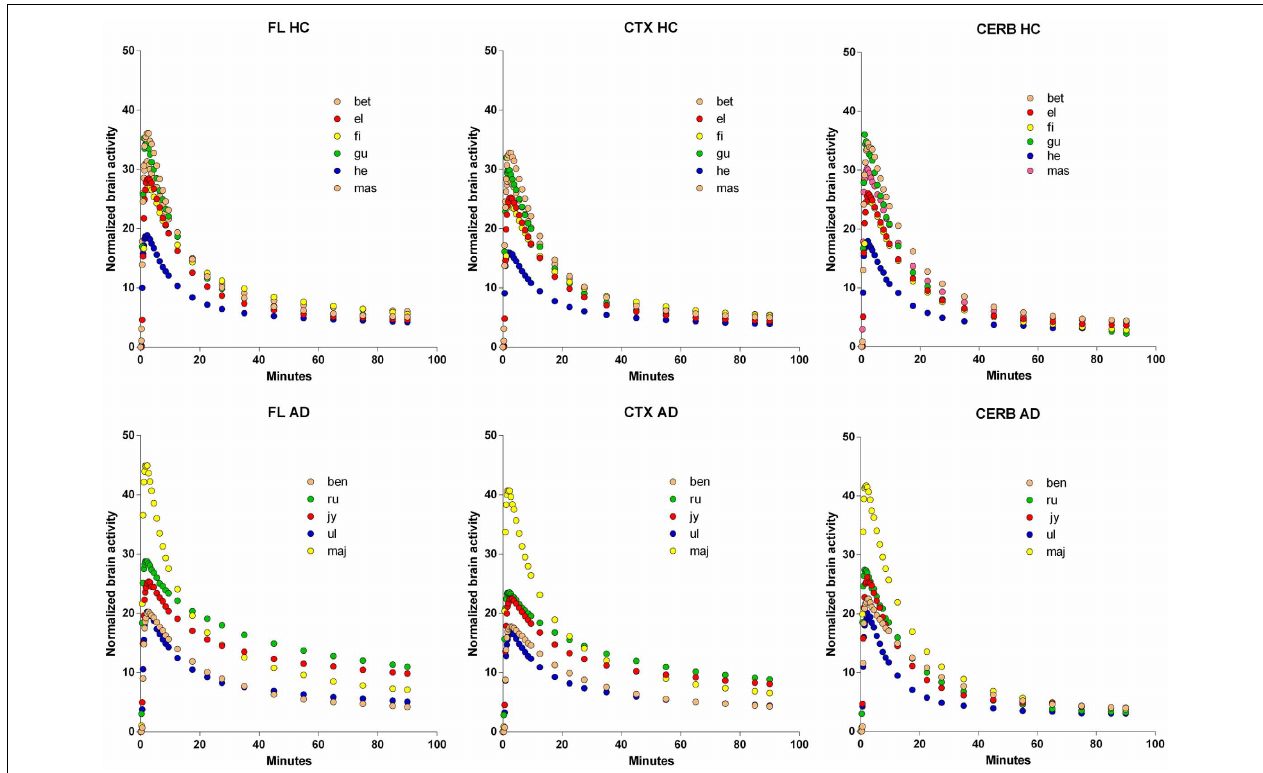
FIGURE 2 | Normalized individual Time-Activity Curves of three brain regions, Frontal Lobe (FL), Cerebral Cortex (CTX), and Cerebellum (CERB), in 6 healthy volunteers (upper row), and